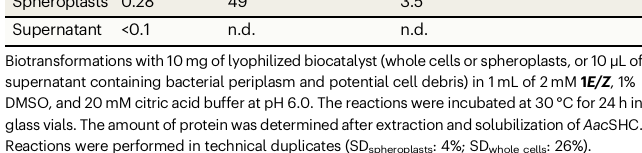
Table 1 | Comparison of the ef fi ciency of whole-cell biocata- lysts and spheroplast biocatalysts using 1E/Z as substrate Fraction Protein (mg) Molar conversion (%) Biocatalyst productivity in 24h (×10 − 3 mmol product /mg protein ) Whole cells 0.8 28